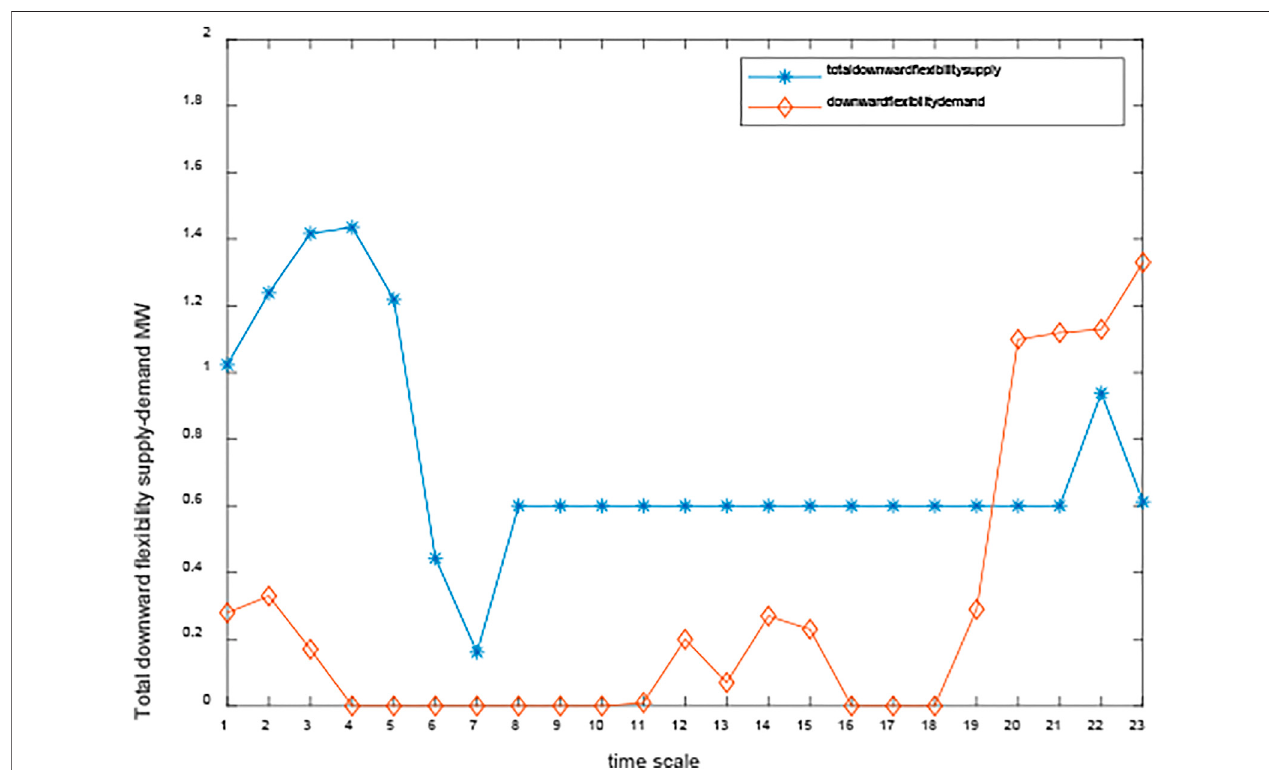
FIGURE 14 | Total downward fl exibility supply – demand of case